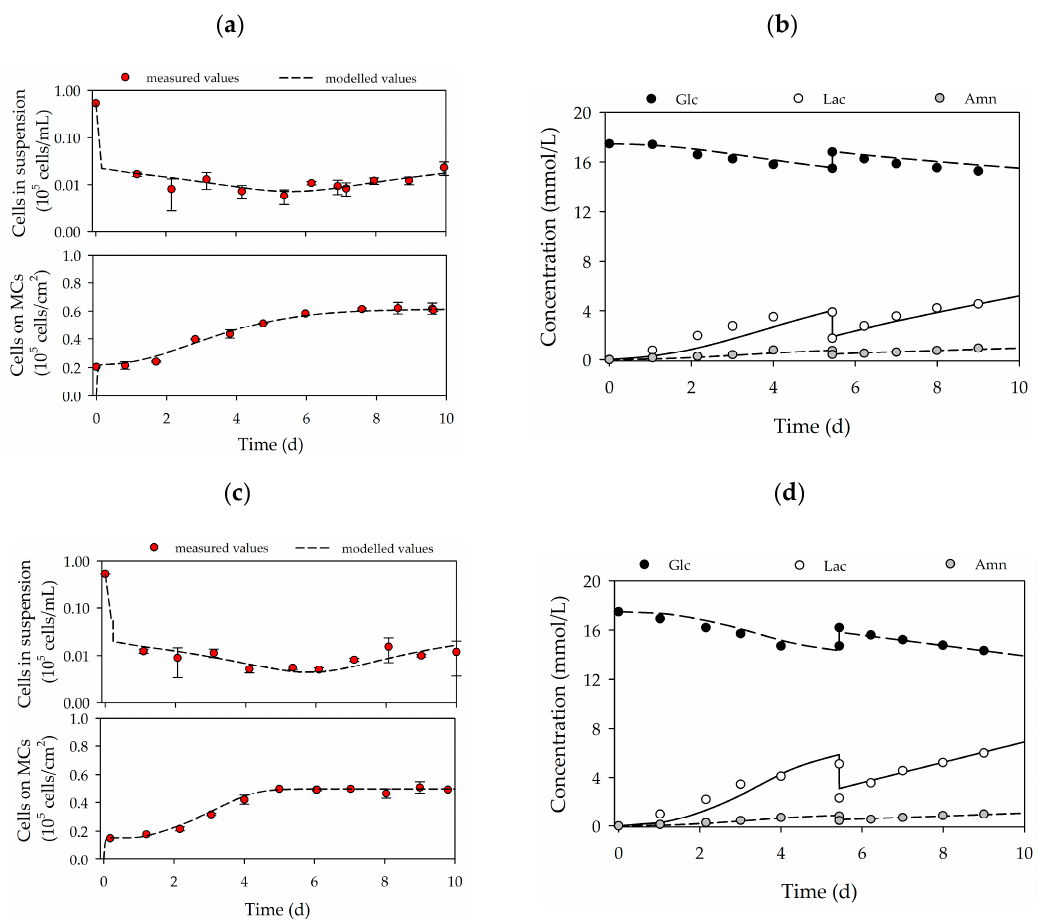
Figure 4. Time-dependent profiles of cell densities ( a , c ) and substrate/metabolite concentrations ( b , d ) in the Corning spinner flasks. Donor 080 (upper row) and 085 (lower row). A partial medium exchange of 50% was performed on day 5. The symbols represent the experimentally measured values collected by offline measurements. The lines represent the simulated time courses.